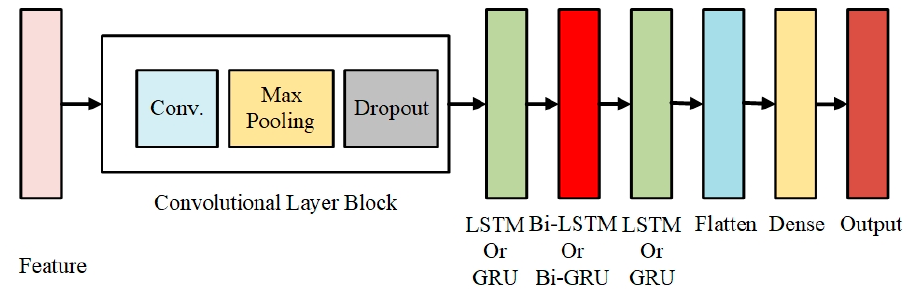
Figure 9. Proposed CNN and variants of RNN (Bi-LSTM/Bi-GRU) architecture .